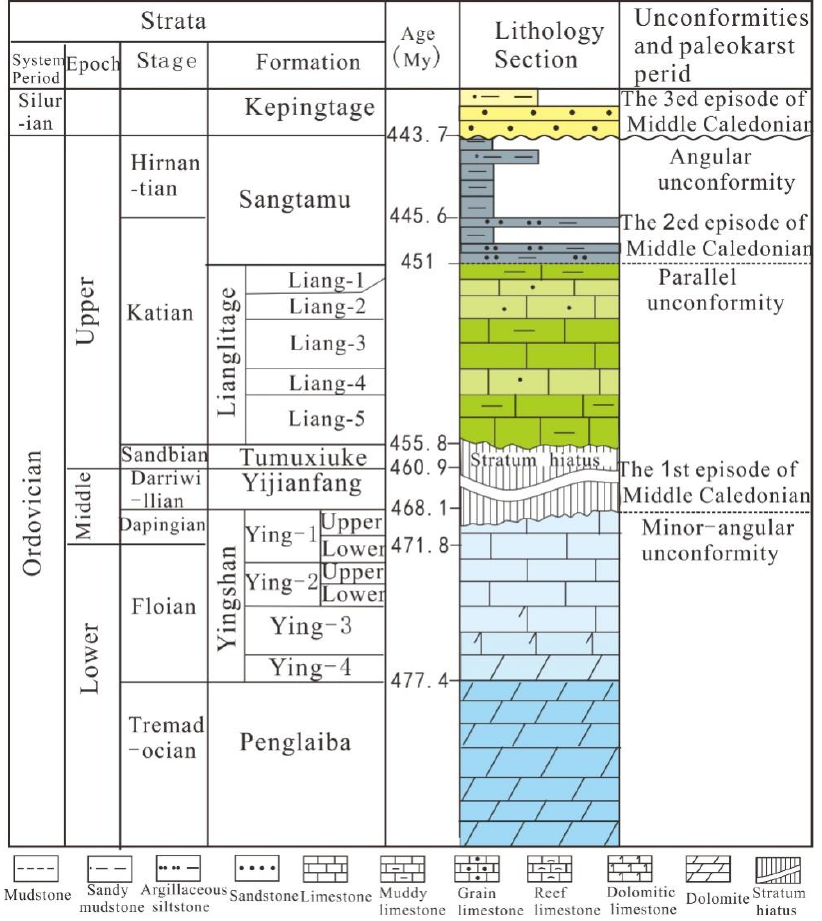
Figure 2. Generalized stratigraphy and associated reservoir intervals (northern slope belt) of the Yingshan Formation in the study area. The stages and ages are from the International Commission on Stratigraphy (2014).